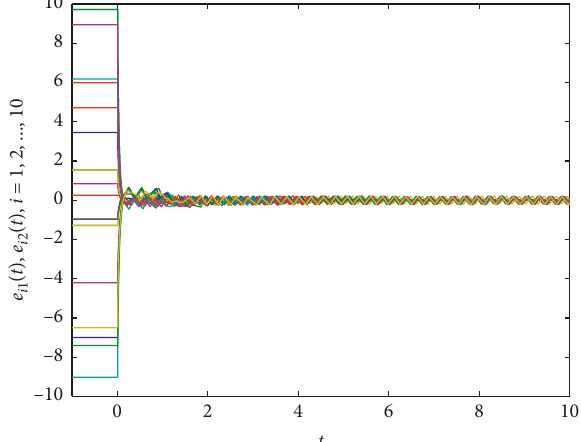
Figure 5: Time evolution of nodes’ states x � 0 . 5 under continuous feedback, i � 1 , 2 , ... , 10. with θ 0